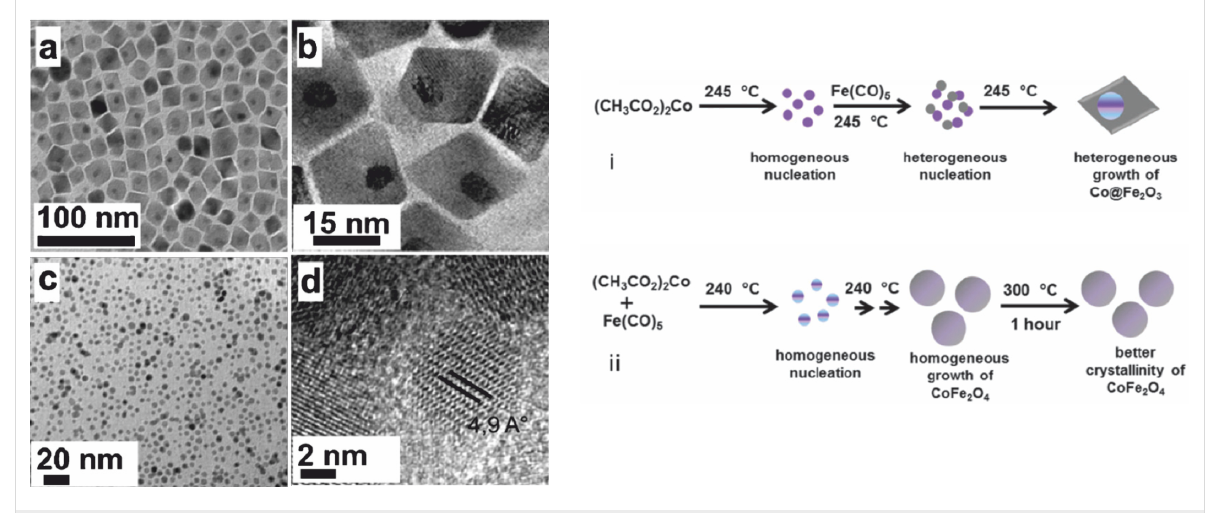
Figure 13: Synthetic protocol of the synthesis of Co@Fe 2 O 3 heterodimer and phase pure CoFe 2 O 4 nanoparticles (top) and corresponding (HR-)TEM images of (a,b) heterodimer particles and (c,d) isotropic CoFe 2 O 4 nanoparticles. Reproduced with permission from [59]. Copyright 2011 The Royal Society of